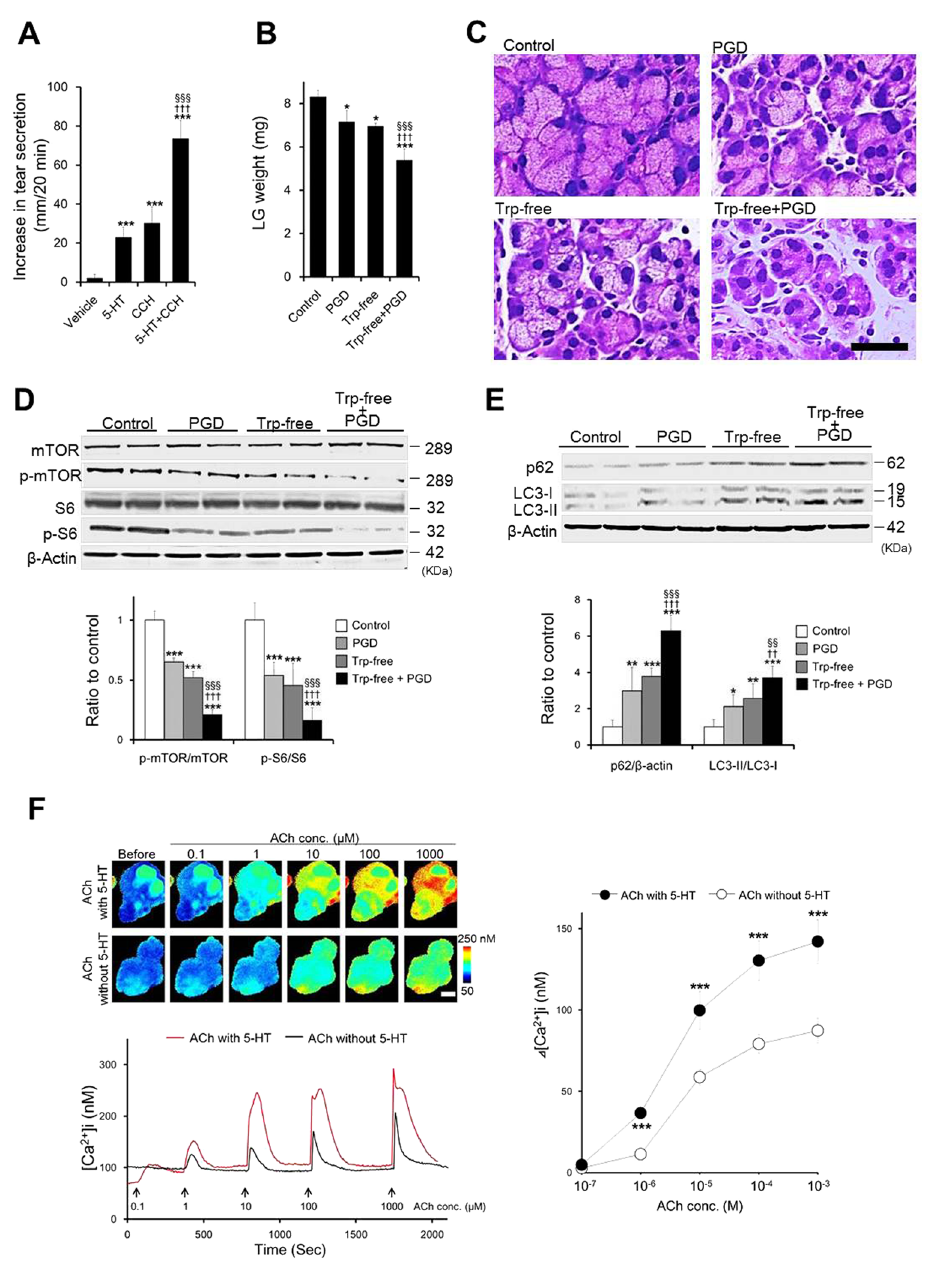
Figure 6. Interaction between parasympathetic stimulation and 5-HT. ( A ) Stimulated tear secretion by 5-HT, CCH, or simultaneous 5-HT with CCH under a condition whereby both parasympathetic and 5-HT stimuli were decreased. Each drug was injected after 1 day of combined PGD and 3 days of Trp-free feeding (n = 5 mice). Sum of tear secretion for 20 minutes after each injection. ( B ) Change in LG weight (n = 6–8 LG) and ( C ) morphology of the LG (scale bar is 10 µ m). ( D ) Change in the phosphorylation levels of mTOR and S6 (n = 6 LG). ( D ) Change in expression levels of p62 and LC3-II (n = 6 LGs). Change in expression level of each protein ( D , E ) was analyzed by western blot at day 1 of combined PGD and 4 days of Trp-free feeding. Representative western blot image and quantitative analysis of western blot (bar chart). The LG was analyzed at day 1 after PGD (PGD), at day 4 after feeding a Trp-free diet (Trp-free), at day 1 after combination of PGD and 4 days of Trp-free feeding (Trp-free + PGD) ( B – E ). ( F ) Interaction between ACh and 5-HT on [Ca 2 + ]i elevation in LG acinar cells (n = 33–35 acini). Acinar cells isolated from normal rat LG were stimulated by ACh at dosages between 0.1 µ M to 1 mM with or without 5-HT at a constant dosage (1 µ M); each stimulation was performed for 1 minute. The upper panel shows pseudocolored images of [Ca 2 + ]i (scale bar, 50 µ m). The lower trace shows the typical response to each stimulus. The arrow indicates the time at which ACh with or without 5-HT was applied to the cells. The line chart show the summarized amplitudes of [Ca 2 + ]i responses. All data represent the mean ± SD, *** P < 0.001 versus